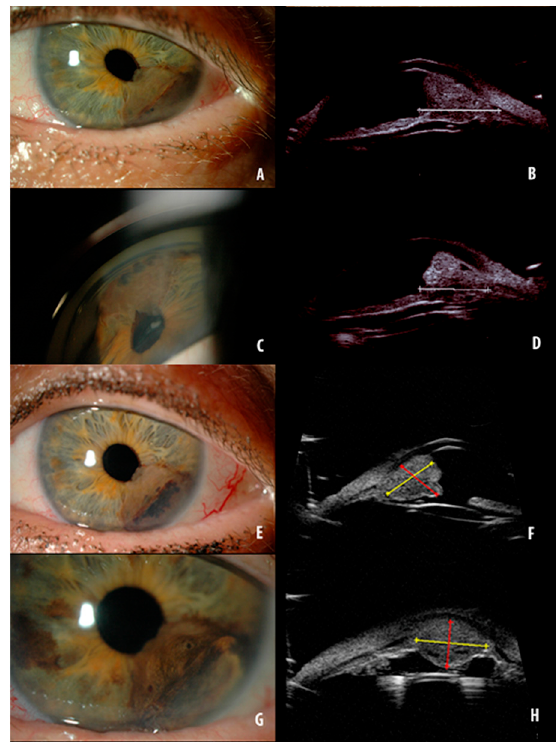
Figure 1. Iris melanoma before proton ‐ beam therapy ( A , C ), Ultrasound Bio Microscopy (UBM) of iris melanoma before proton ‐ beam therapy, with a size of 5.9 × 4.4 mm. ( B , D ). Iris melanoma 6 months after proton ‐ beam therapy ( E , G ), UBM of iris melanoma 6 months after proton ‐ beam therapy with a size of 5.3 × 4.1 mm ( F , H ).